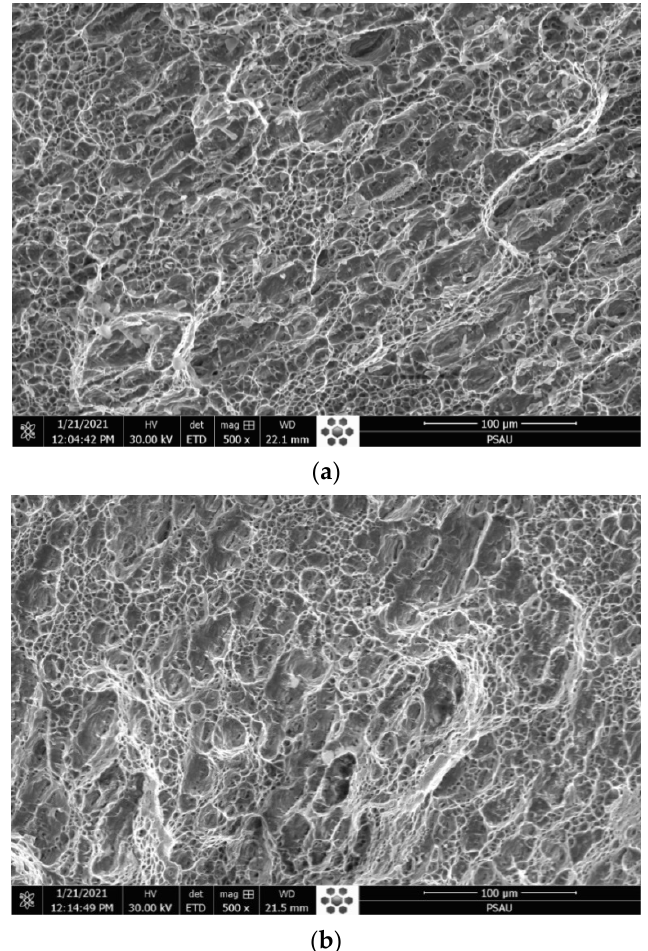
Figure 6. Fractograph of austenitic stainless steel 316L tensile test for TIG ( a ) and ATIG ( b ) welds (500×).